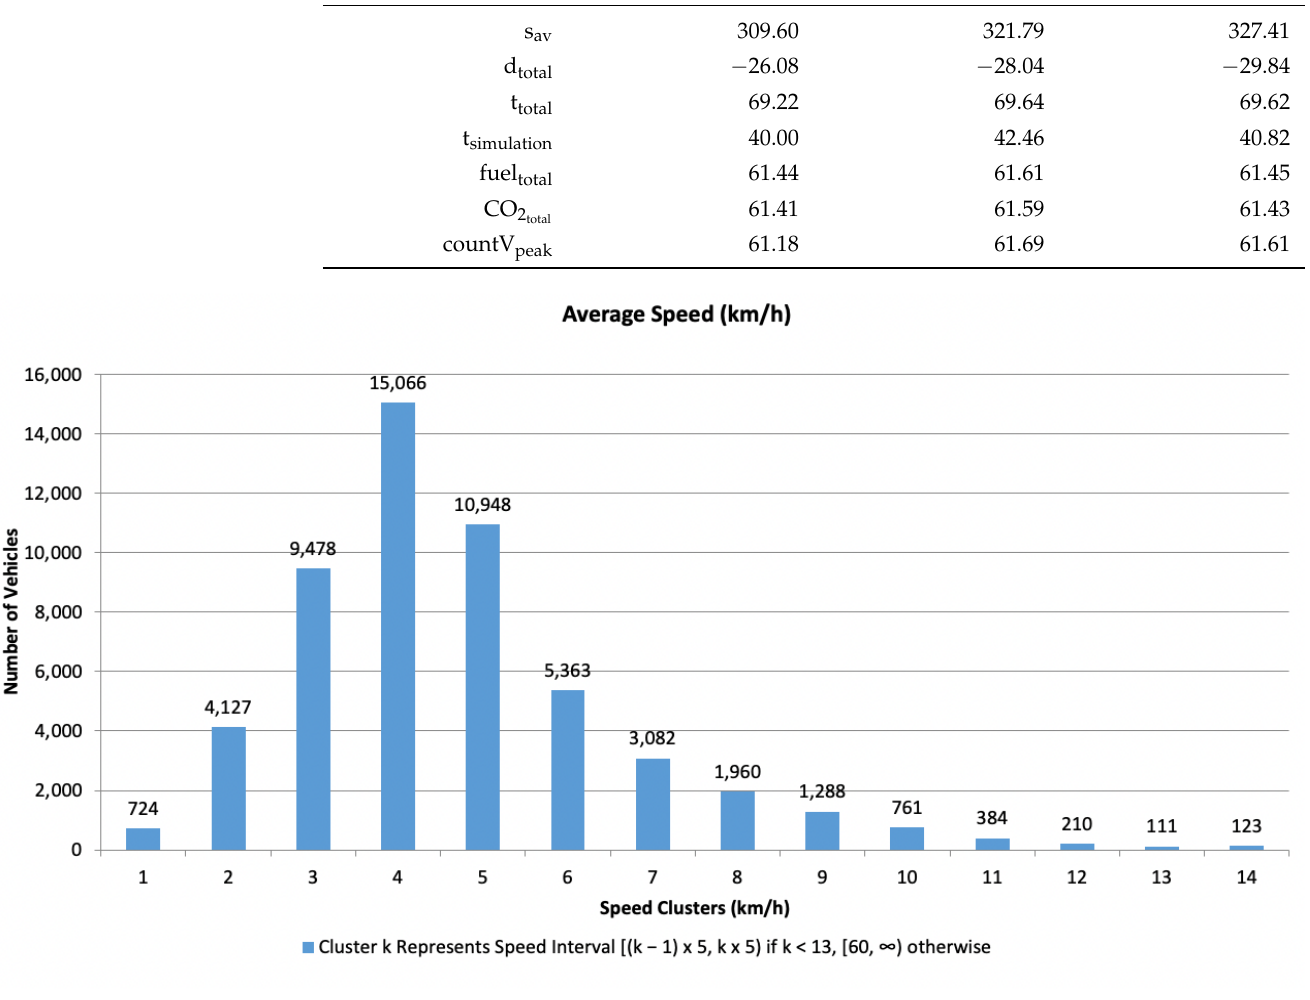
Figure 8. Speed distribution in clusters for 50 K+ simulated vehicles in Tokyo with δ =